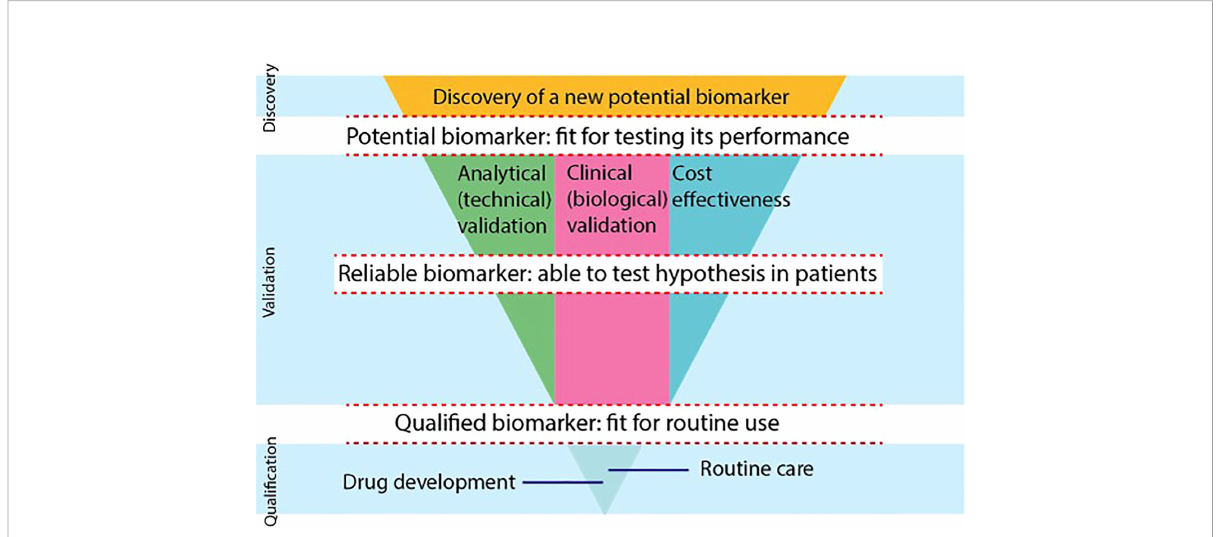
FIGURE 3 The biomarker development process is shown using a modi fi ed scheme, based on the consensus statement on biomarker development of the CRUK and EORTC (59). There are 3 phases of development (discovery, validation, quali fi cation) that biomarkers go through. Biomarkers need to overcome gaps to become potential biomarkers, reliable biomarkers and quali fi ed biomarkers. In the validation phase, 3 separate tracks will be evaluated in parallel and iteratively, i.e., the analytical, clinical and cost-effectiveness track. To be able to use a biomarker in drug development or in routine clinical care, biomarkers need to provide quali fi cation evidence. (*) The FDA Evidentiary Framework provides recommendations that guide the evidence needed to support quali fi cation, bridging the fi nal gap to routine care and drug development in the quali fi cation